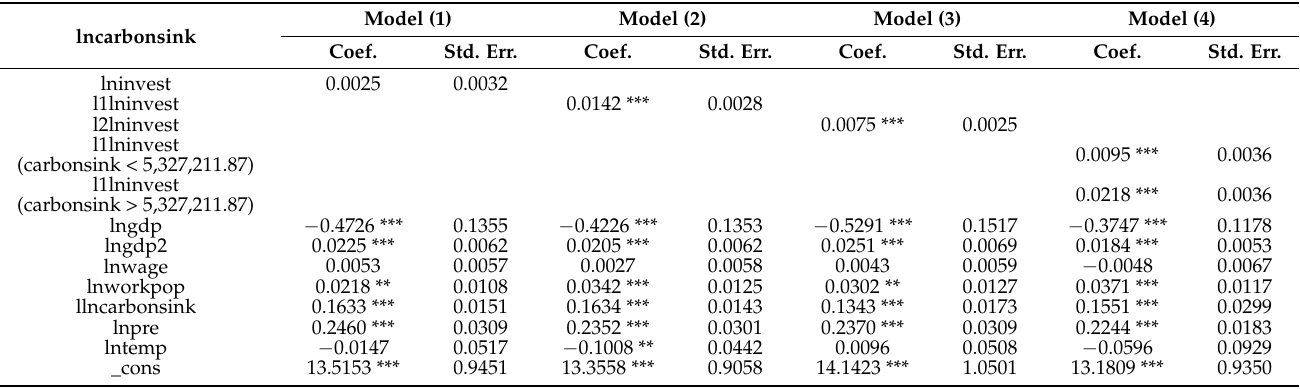
Table 4. Test results of threshold effect.